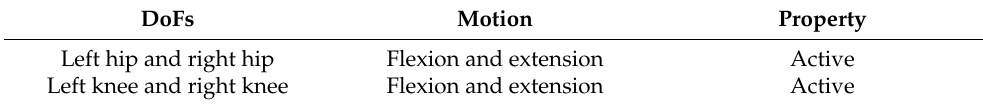
Table 1. Motion and DoFs of the wearable lower-limb rehabilitation robot. DoFs Motion Property Left hip and right hip Flexion and extension Active Left knee and right knee Flexion and extension